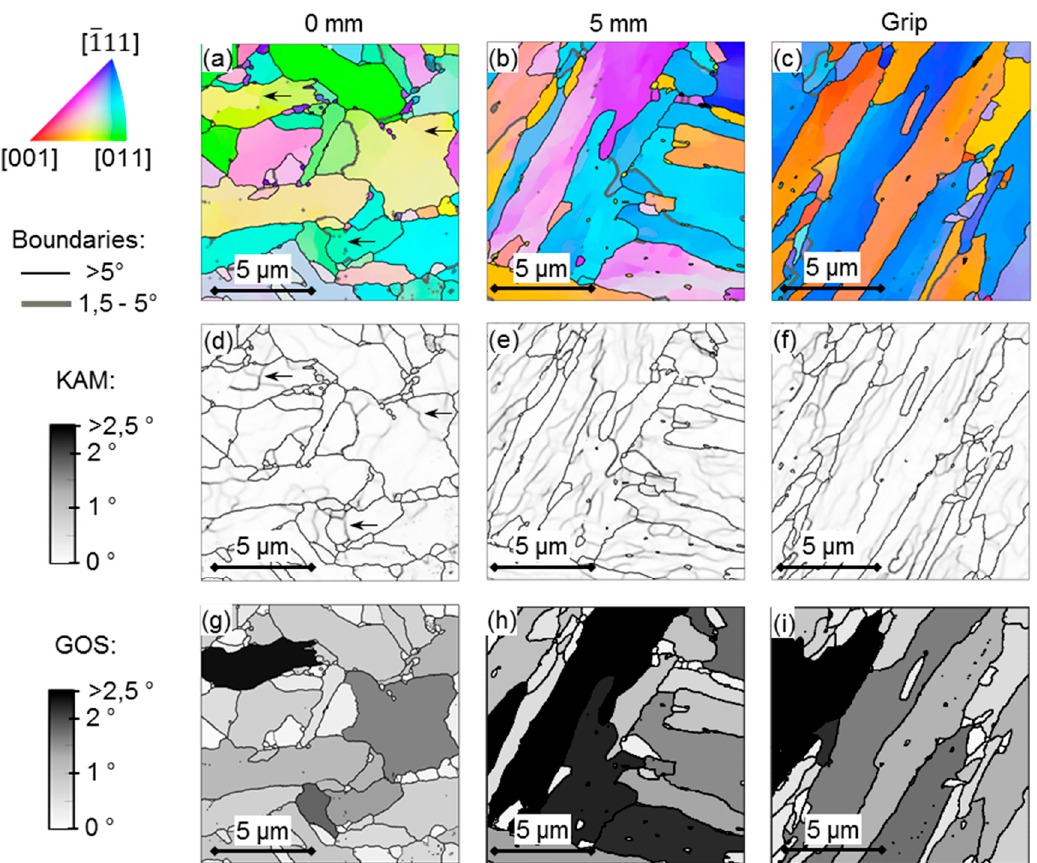
Figure 10. ( a – c ) IPF maps showing crystal orientations relative to the sample normal according to the colour key (top left), ( d – f ) Kernel Average Misorientation (KAM) maps and ( g – i ) grain orientation spread (GOS) maps of areas at 0 mm and 5 mm from the maximum temperature gauge region and at the grip of the EXL material.